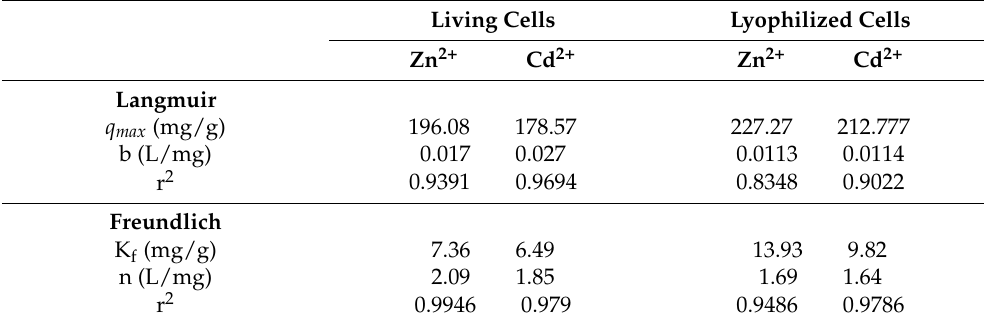
Figure 7. Linear form of Freundlich adsorption isotherms for adsorption of Zn 2+ and Cd 2+ by living ( a ) and lyophilized ( b ) cells of Priestia megaterium PRJNA526404. Table 2. Langmuir and Freundlich adsorption constants calculated from the Langmuir adsorption isotherms of Zn 2+ and Cd 2+ by living and lyophilized biomass of Priestia megaterium PRJNA526404.